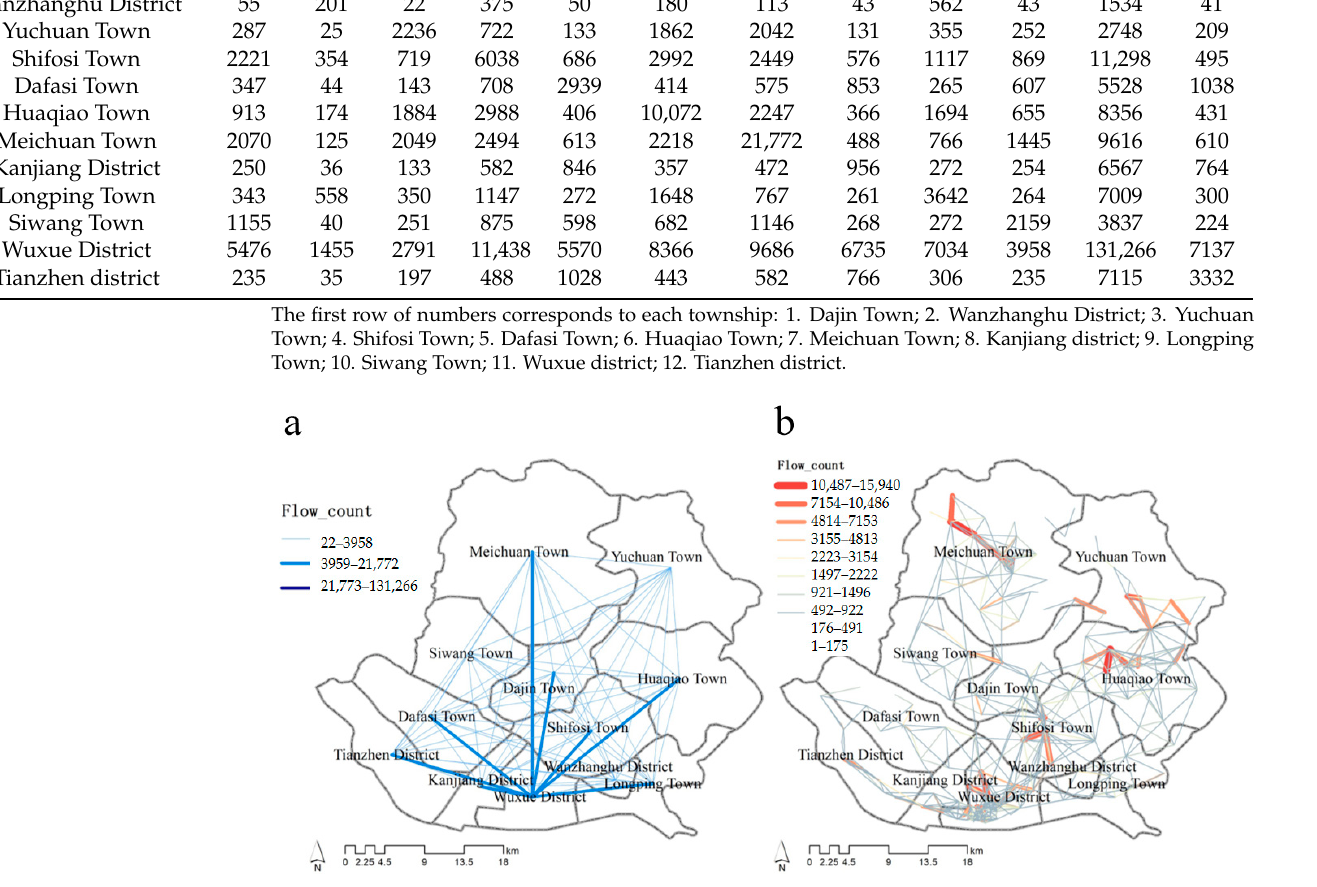
Figure 6. Spatiallinkageintensitybetweendifferentregions. ( a )Administrativedistrictlevel. ( b ) Township Figure 6. Spatial linkage intensity between different regions. ( a ) Administrative district level. ( b ) Township district level. district